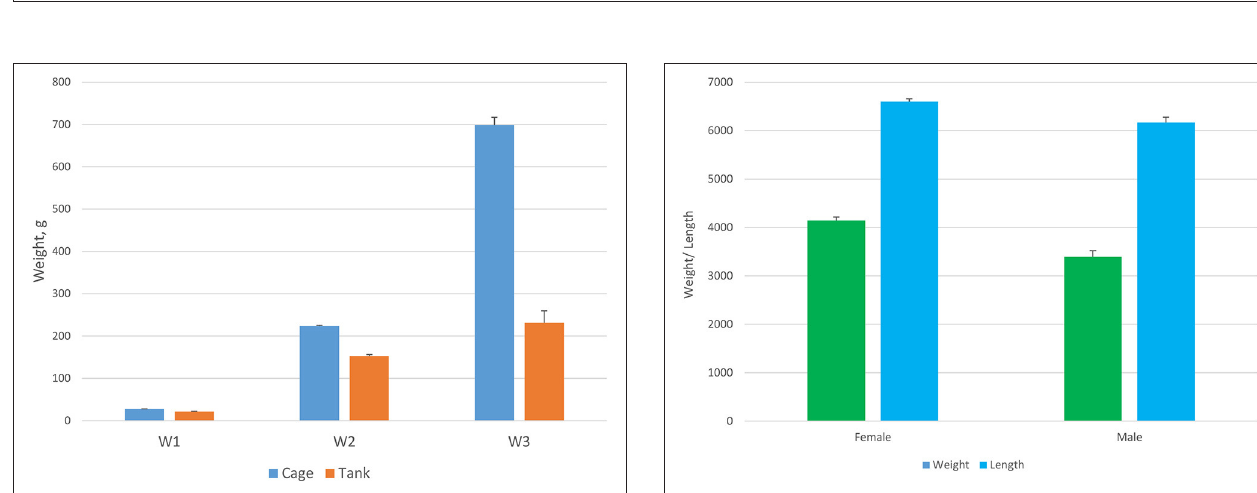
100) of female and male ×